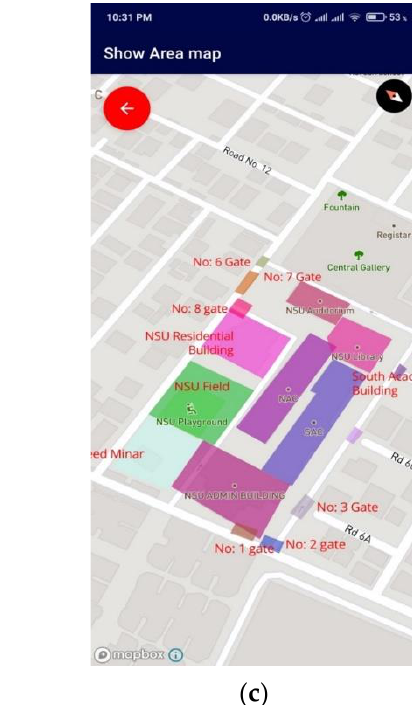
Figure 13. Applications ’ layout of ( a ) Institutional user window, ( b ) list of saved Institutional maps, and ( c ) showing the saved Institutional map.